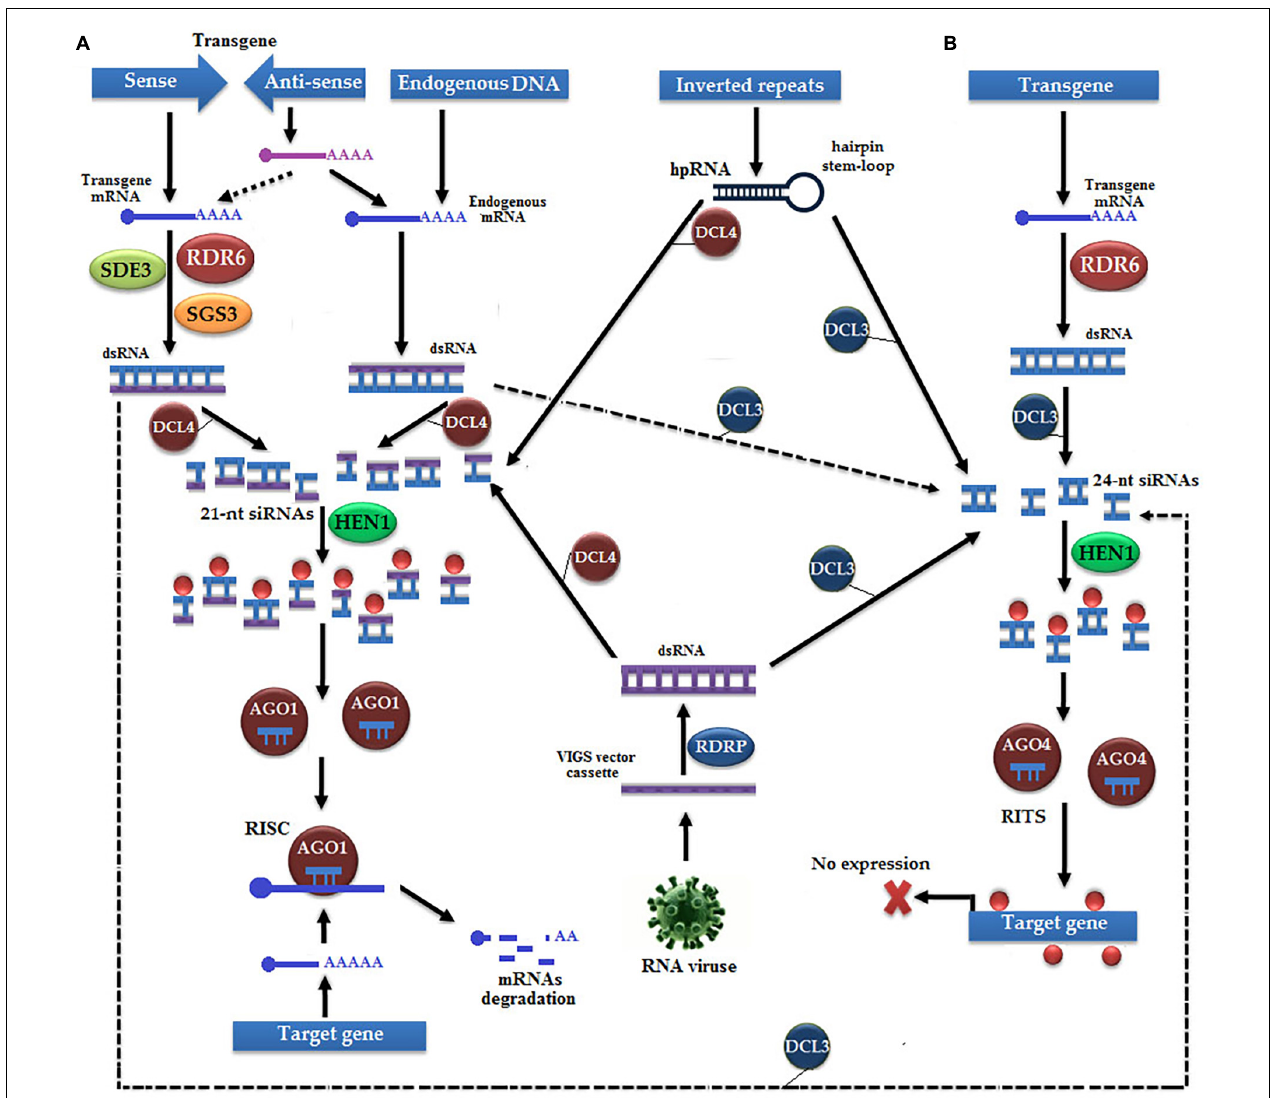
FIGURE 6 | Transgene silencing occurs by the following two pathways: (A) post-transcriptional gene silencing (PTGS), which is initiated by sense or antisense transgenes, IR, hp-RNAs, and virus-induced gene silencing (VIGS). The sense strand is transcribed into mRNA, and transformed into dsRNA under the action of RDR6, suppressor of gene silencing 3 (SGS3), and RNA helicase (SDE3). Subsequently, dsRNA is either transformed into methylated 21-nt siRNAs by Dicer-like 4 (DCL4) and Hua Enhancer 1 (HEN1) or transformed into 24-nt siRNAs by AGO3 to cause gene silencing by the TGS pathway. The 21-nt siRNAs bind with AGO1 to make the RNA-induced gene silencing complex (RISC) that causes the degradation of mRNA of the target gene. Antisense strand is transcribed into mRNA, which either follows the same pathway with sense strand, or, like endogenous mRNA, transformed into dsRNA and bind with AGO to trigger the RISC. IR and VIGS follow either of the two available silencing pathways depending on the type of DCL. (B) TGS pathway, which is initiated with the transcription of transgene, dsRNA is formed under the action of RDR6, which is further cleaved into 24-nt siRNAs by DCL3, is methylated with HEN1, and make the RNA-induced transcriptional silencing (RITS) complex with the help of AGO4, which finally causes